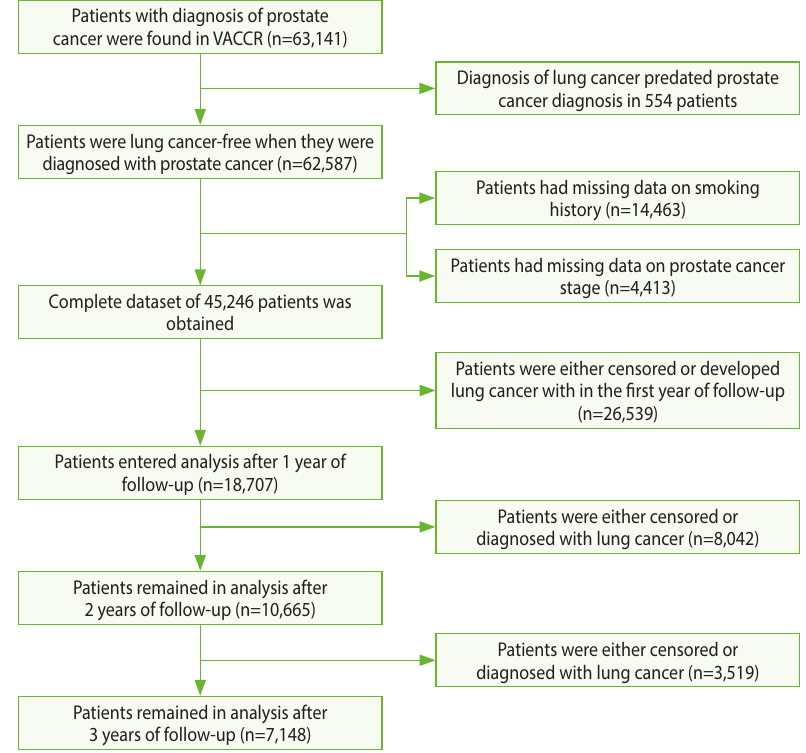
Figure 1. Identification and processin of patients’ data. VACCR, Veterans’ Affairs Central Cancer